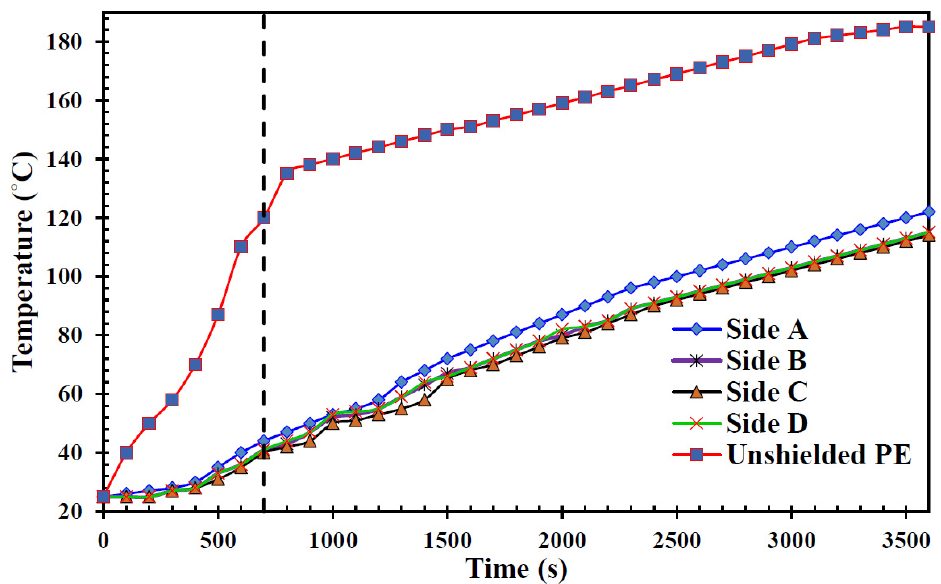
Figure 17. The temporally evolving maximum temperature along the four sides of the mild steel shield and the unshielded polyethylene.